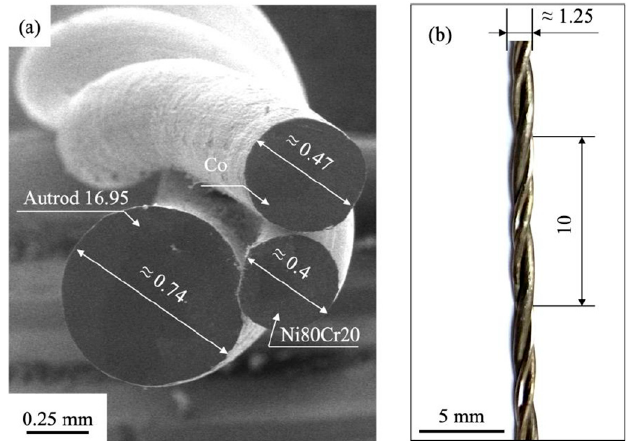
Figure 14. ( a ) SEM image of CCW composed from three stranded wires (pure Co wire, Autrod 16.95 welding wire and Ni80Cr20 wire, ( b ) photograph of the CCW wire [202].